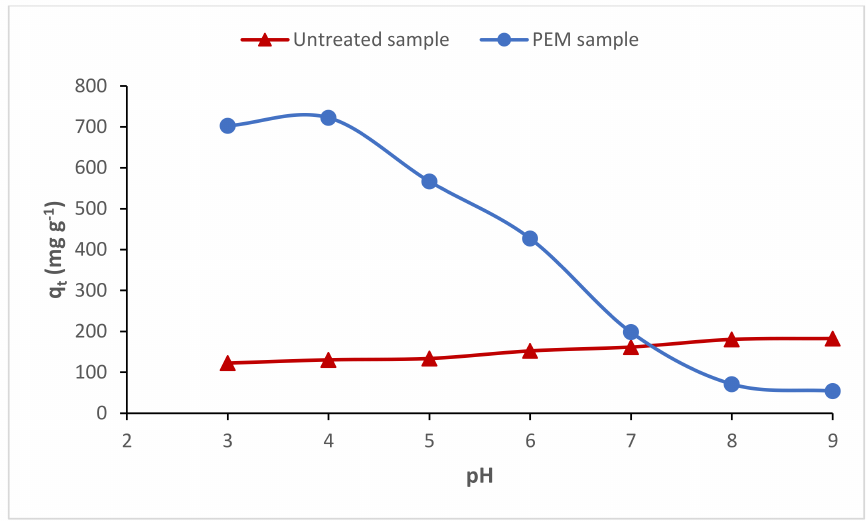
Figure 7. Effect of pH on the adsorption of RR198 onto untreated cellulosic sample and the PEM bio-sorbent